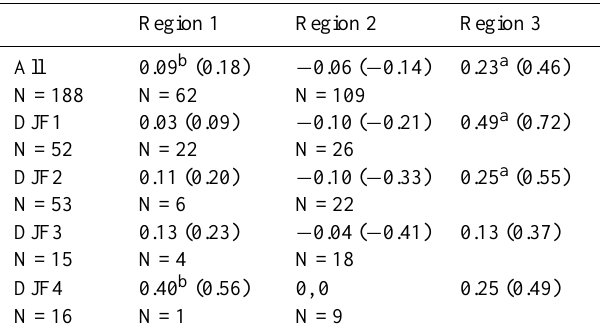
Surface level CO export case on January 27, 2006, (a) GOES-East IR satellite image for 06:15UTC with TES 681hPa CO (ppbv) plotted in colored dots (b) TES CO retrieved profiles (in oval) and universal a priori profile (ppbv) for 06:00UTC and (c) Skew-T sounding plot from Wallops Island, VA for 00:00UTC showing parcel ascent in red. The blue arrows on a) show the sur- face wind directions and sea surface temperatures from buoy mea- surements are plotted with red numbers. Table 2. DJF O 3 -CO slope (molmol-1), correlation coefficient ( r ) and sample size (N) for circulation types in the three regions shown in Fig. 3a. The superscripts a and b indicate slope significance at the p =0.01 and 0.05 levels respectively. The slopes without super- scripts had p values greater than 0.10 and were thus not considered significant to a high degree but are shown for completeness.